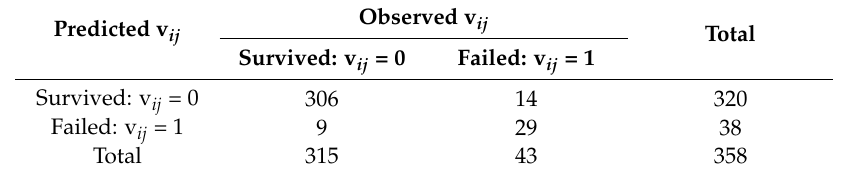
Table 4. Classification table for a discrete hazard model of Equation (13e) with c = 0.5.